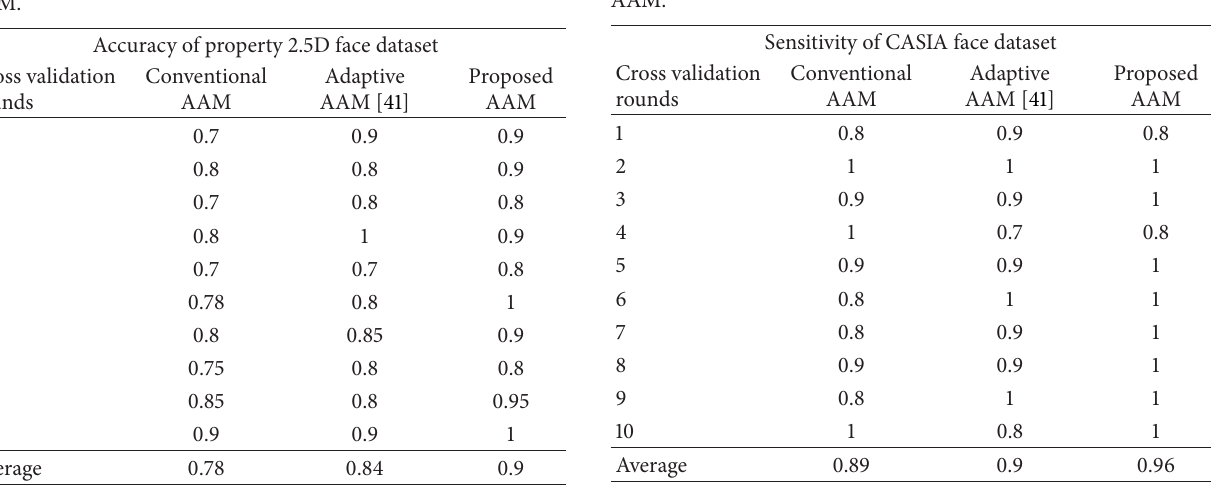
Table 6: Cross validation results for CASIA face dataset in terms of sensitivity for conventional AAM, adaptive AAM, and the